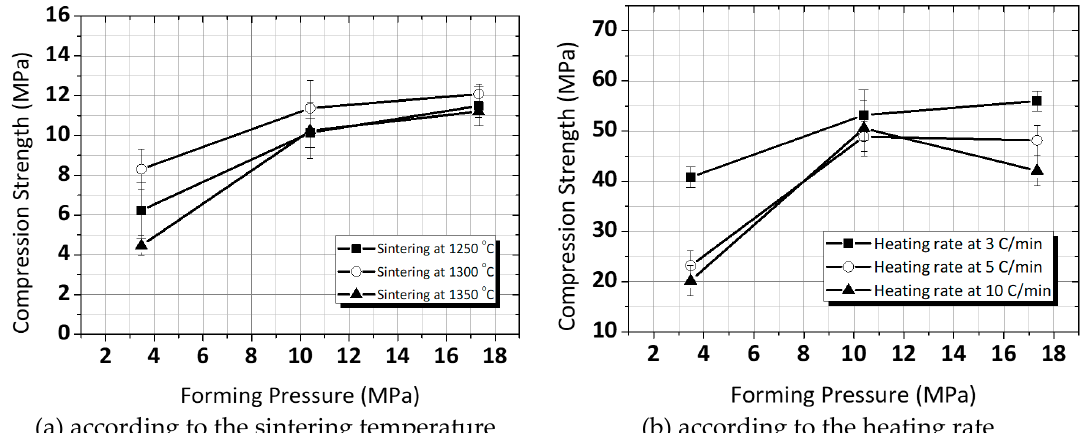
Figure 4. Compression strength of the ring-type PZT ceramics: ( a ) in accordance with sintering temperature ( b ) in accordance with the heating rate (fixed sintering temperature at 1300 °C).